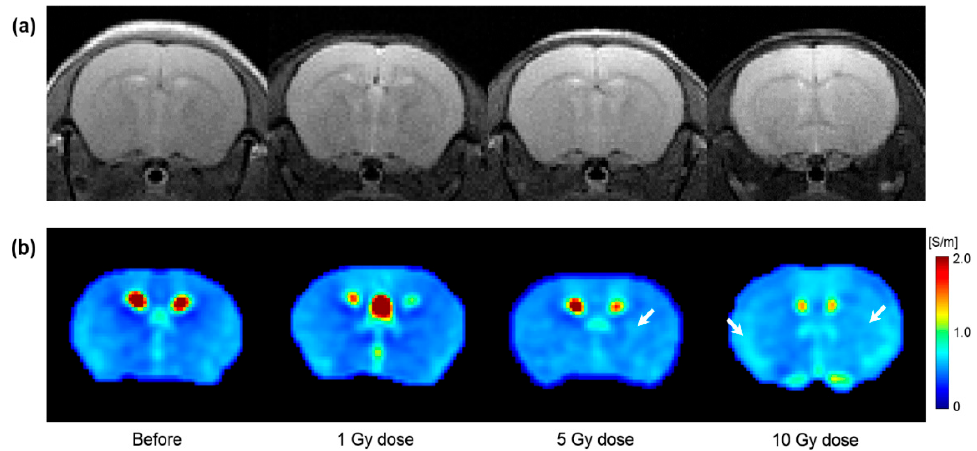
Figure 4. T2-weighted ( a ) and electrical conductivity ( b ) images of in vivo mouse brains with respect to tissue response by different irradiation doses. All images were acquired 1 day after irradiation. White arrows indicate the increase in conductivity contrast.